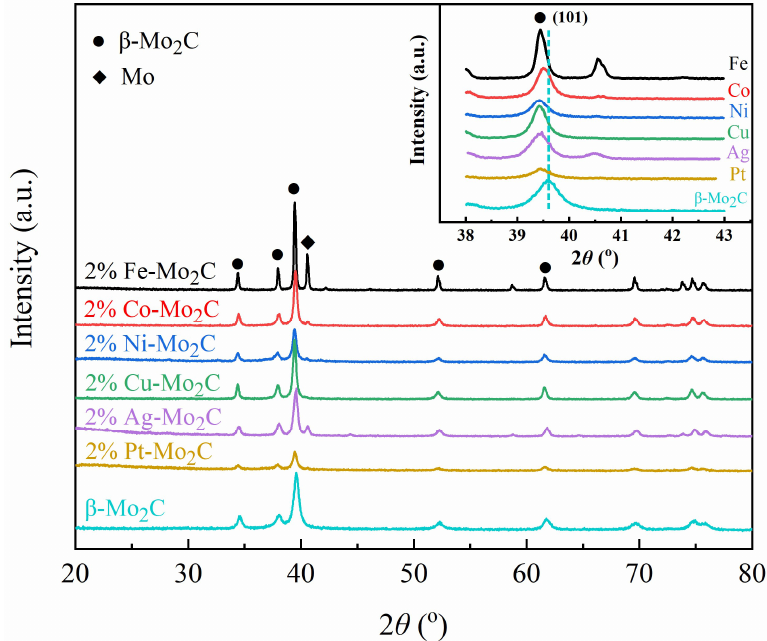
Figure 1. X-ray diffraction (XRD) patterns of various metal doped molybdenum carbides and pure β-Mo 2 C.